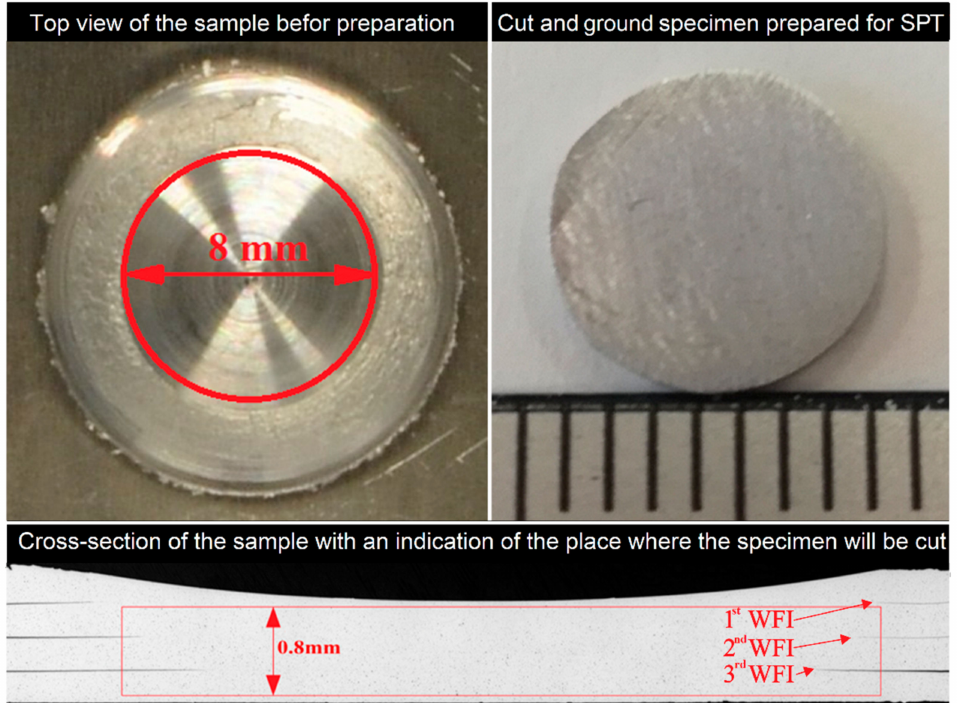
Figure 2. Preparation of the small punch test (SPT) specimen; the top figure shows the 8 mm diameter of the sample (width measurement in the bottom figure) such that the thickness of the sheet was 0.8 mm (WFI–weld faying